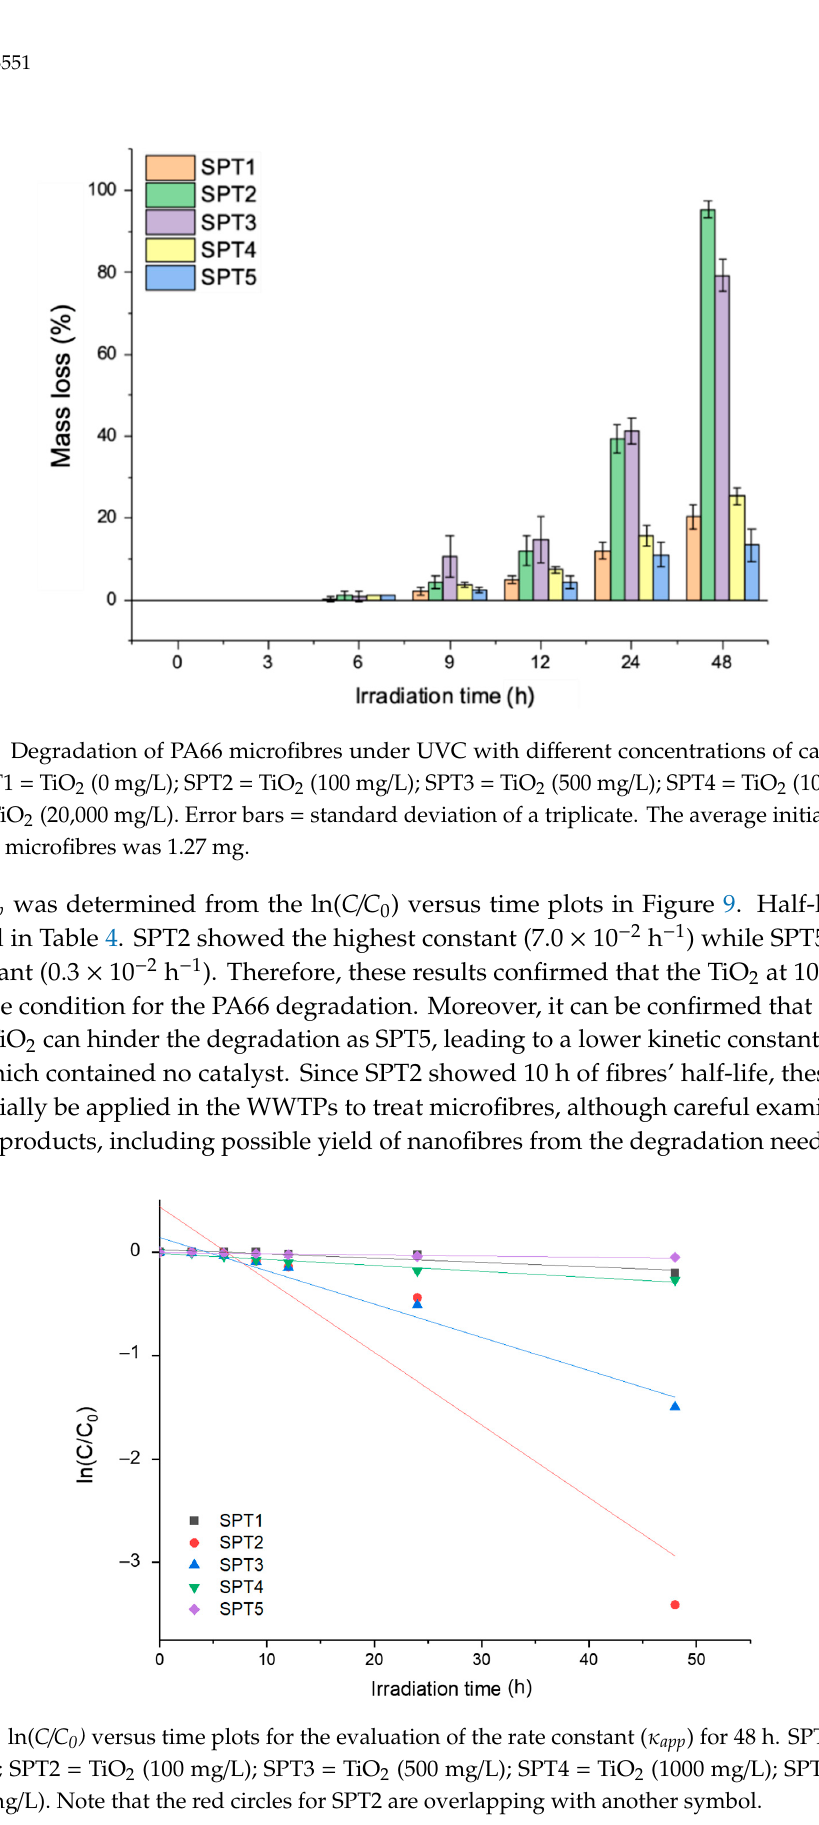
11 of 23 Figure 7. Evaluation of the apparent reaction rate constant ( (cid:2018) (cid:3028)(cid:3043)(cid:3043) ) of SP1-SP6. 3.2. Mass Loss and Photocatalytic Degradation Kinetics: Effects of the Concentrations of Catalysts To assess the effects of the concentration of the catalyst on the degradation rate of PA66 microfibres, a second experiment was performed to test the effect of different doses of TiO 2 (up to 20 g/L) under UVC for 45 h. As shown in Figure 8, the conditions tested in SPT2 (100 mg TiO 2 /L) showed 97% of mass loss in 48 h, followed by 78% for SPT3 (500 mg TiO 2 /L) and 24% for SPT4 (1000 mg TiO 2 /L) while SPT1 (no TiO 2 ) and SPT5 (20,000 mg TiO 2 /L) resulted in the least mass loss of 18% and